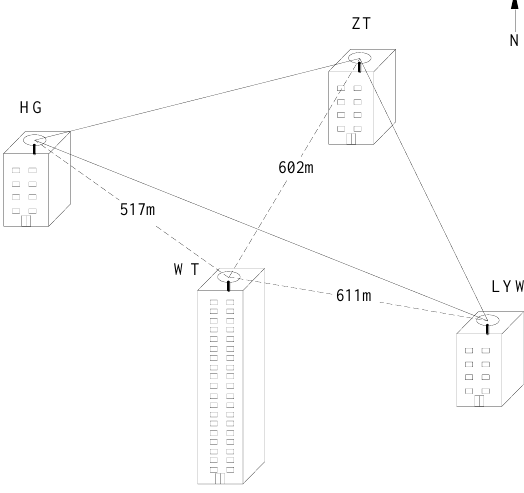
Figure 6. GNSS monitoring network.